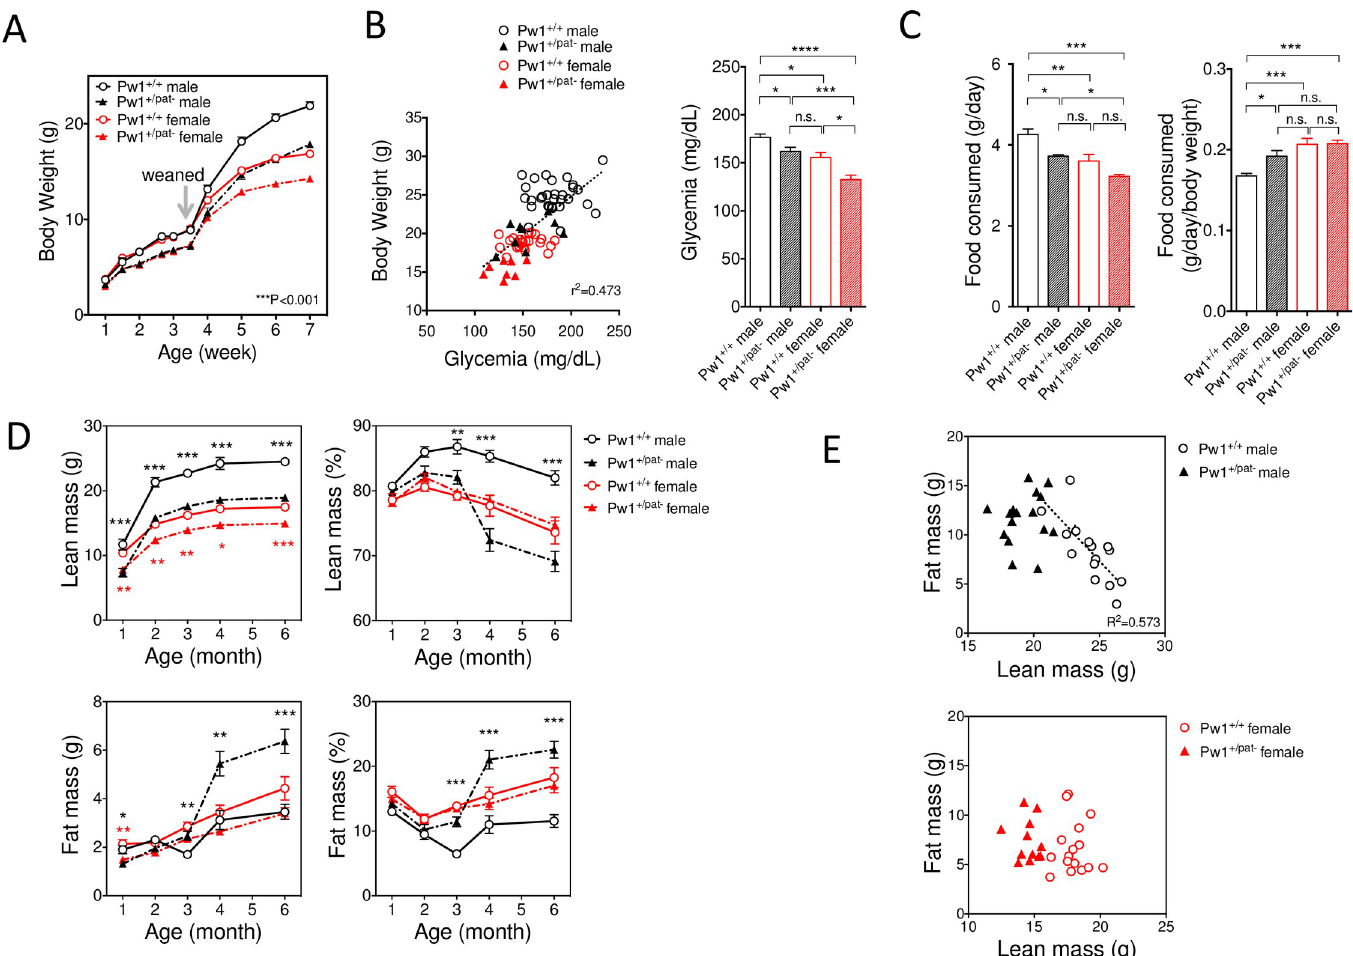
Fig 1. Reduced masculinization of metabolisms in Pw1 +/pat- males. ( A ) Postnatal growth of Pw1 +/pat- compared with Pw1 +/+ littermates showing Pw1 +/pat- animals are smaller in both sexes throughout the growing phase (p < 0.001), and the onset of sexual dimorphism in body weight is delayed in Pw1 +/pat- at four weeks of age. Two-way ANOVA test revealed significant interaction between genotype and sex after 6 weeks of age. ( B ) Random-fed glucose levels at 2 month-old and its positive correlation with body weight (r = 0.690, p < 0.0001). Each symbol represents independent measurement. ( C ) Sex dimorphic food consumption at 2 month-old. Two way ANOVA test with multiple comparisons demonstrated significant interaction between sex and genotype. ( D ) Sexual dimorphisms in body composition in young adults (n = 8–14 each group). Male-specific increase in lean mass and decrease in fat mass in Pw1 +/+ males at 2–3 month of age was less prominent in Pw1 +/pat- males, while the females Pw1 +/pat- are proportionally smaller in lean and fat mass. � in black represents comparison in males and � in red represents comparison in females. ( E ) An inverse correlation between lean mass and fat mass at 10 month of age was only found in the Pw1 +/+ males (r = 0.757, p < 0.001) and not in the Pw1 +/p- males (r = 0.076, p = 0.771) nor in the females (r = 0.006, p = 0.981). Comparison between genotypes and sexes was performed using two-way ANOVA with Tukey’s multiple comparisons. Correlation was determined with simple linear regression analysis. � P < 0.05, �� P < 0.01, and ��� P < 0.001. NS: non-significant. Values are mean ± SEM. Each symbol represents individual animals in ( B ) and ( E